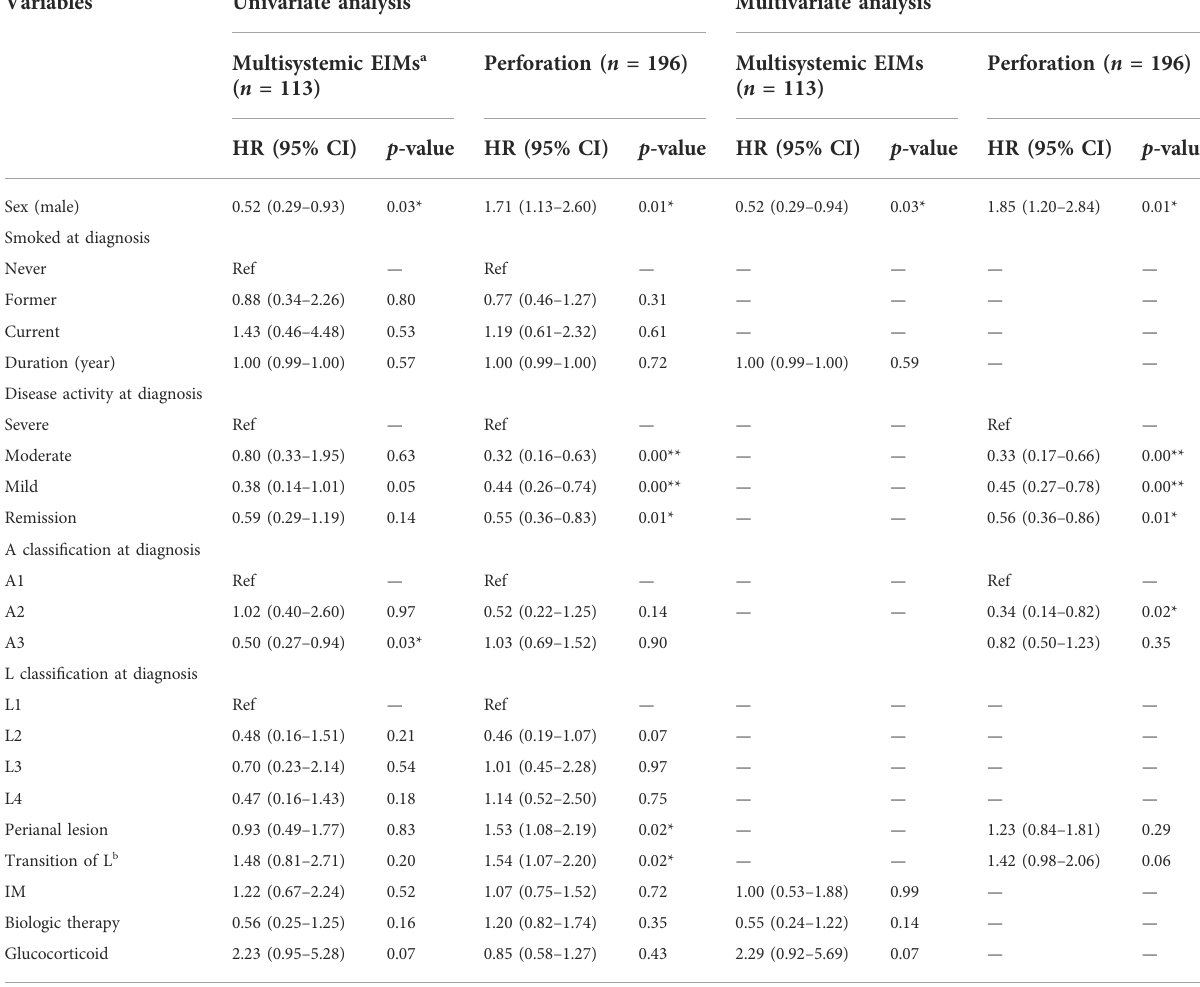
TABLE 2 Univariate and multivariate Cox regression analysis of risk factors for multisystemic EIMs and intestinal perforation in CD